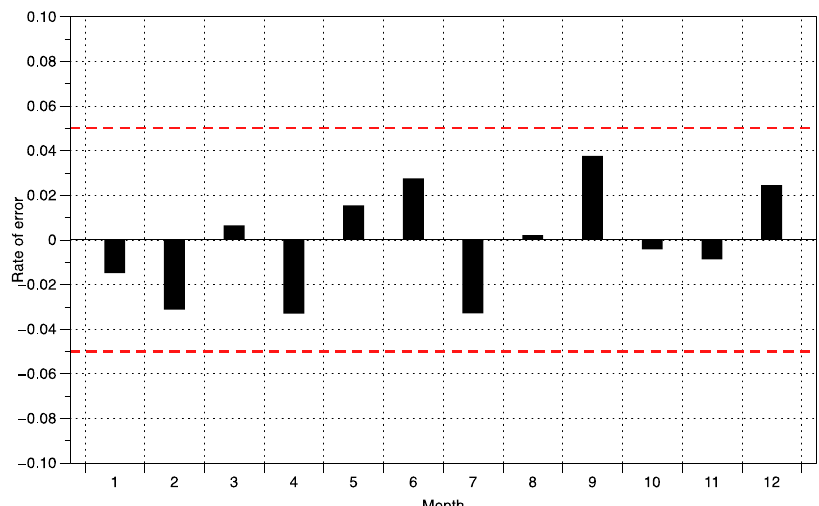
Figure 11. Error distribution of monthly total energy consumption.